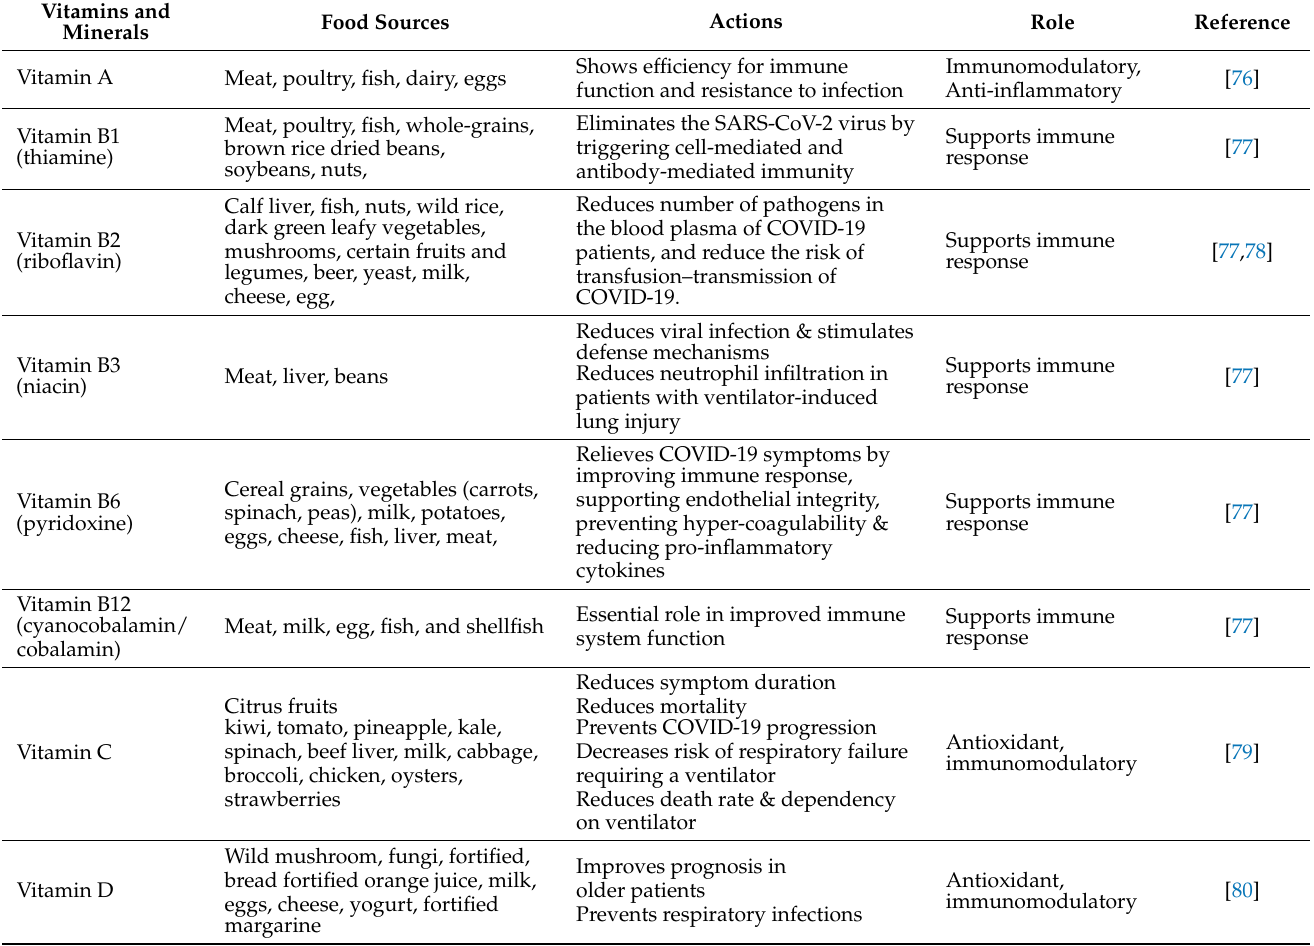
Table 1. Micronutrients and their role in